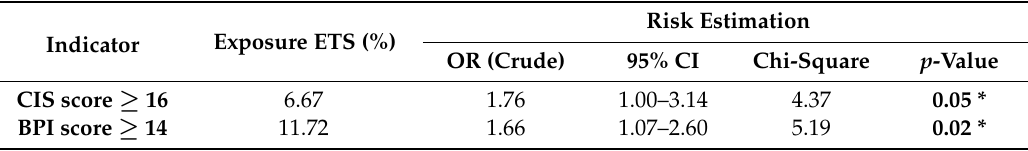
Table 3. Relations between behavioral functions (BPI) and emotional functions (CIS) and the exposure of children to father’s or mother’s smoking at home ( n = 1373) (bivariate analysis).